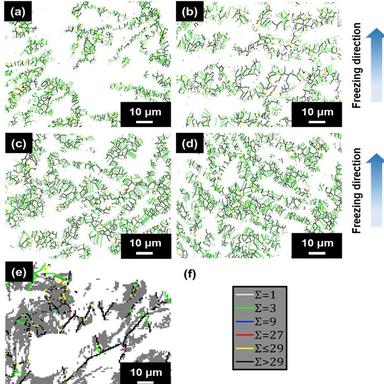
Grain boundary character maps: (a, c) Perpendicular and (b, d) parallel to freezing direction of Ni foam with varying oxide slurry fraction: (a, b) 5 vol% and (c, d) 7 vol%, and (e) commercially available Ni foam. Low-angle boundaries (LABs) and special boundaries including Σ3, Σ 9, Σ 27, Σ ≤ 29, and Σ > 29 are based on the (f) Coincidence Site Lattice (CSL) grain boundary legend.